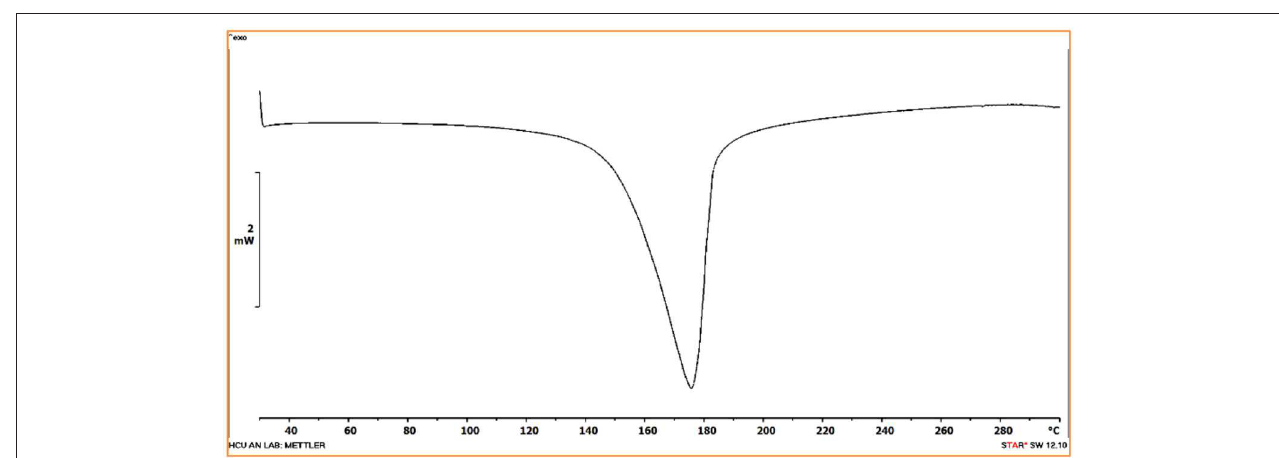
FIGURE 4 | Differential scanning calorimetry (DSC) of compound 1